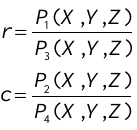
Table 1 Parameters of the GA used in RFM